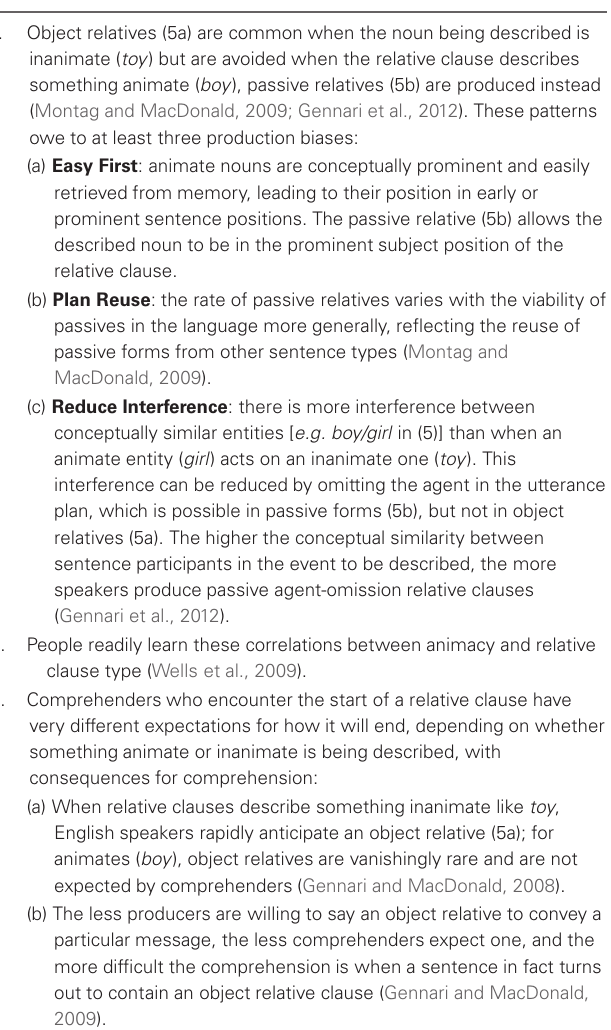
Table 2 | PDC account of greater comprehension difficulty for object than subject relative clauses (citations refer to English